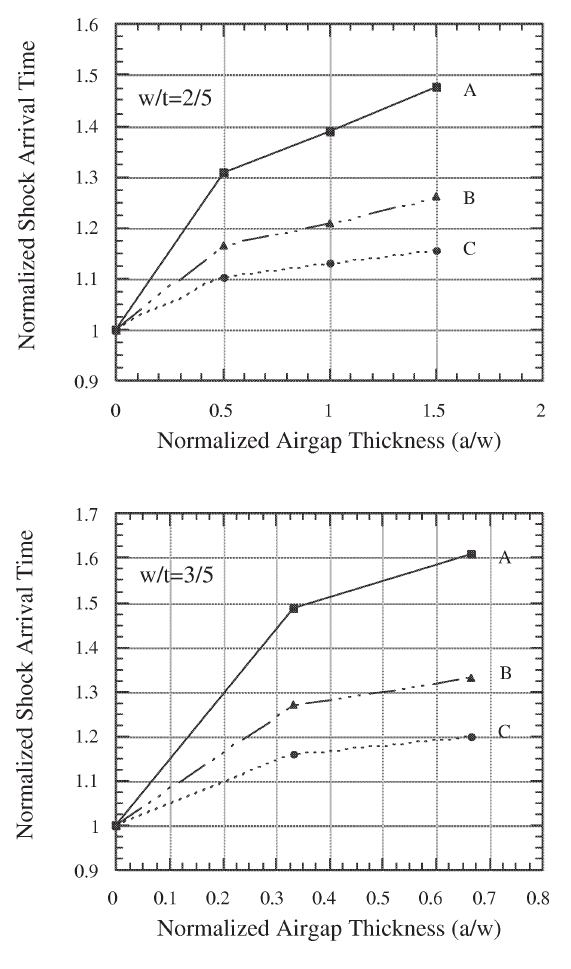
Fig. 10. Normalized shock arrival time of non-contact watershield, w=t = 2 , w=t = 3 . 5 5